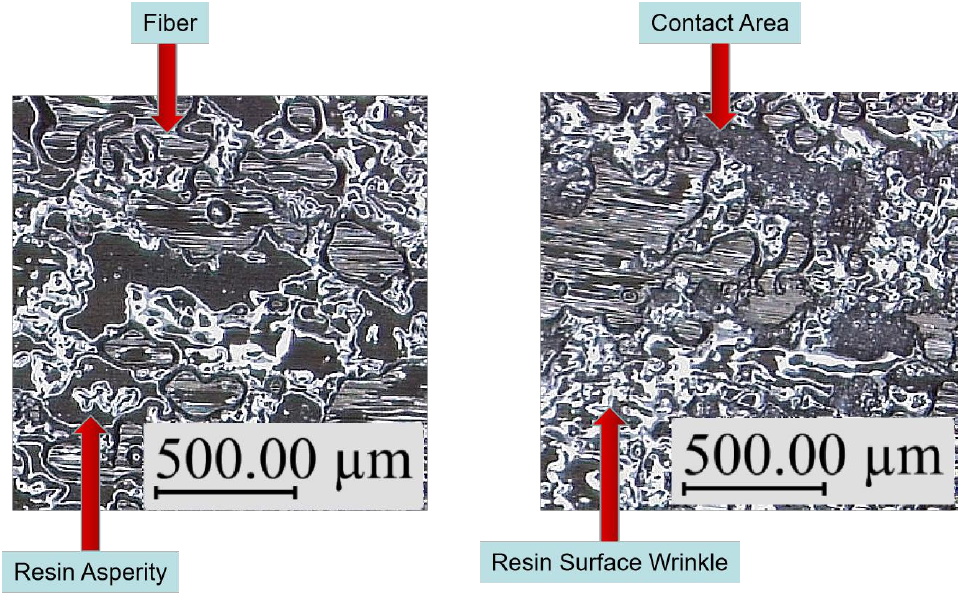
Figure 14. The contrast of prepreg raw surface ( left ) and separated probe test sample ( right ).